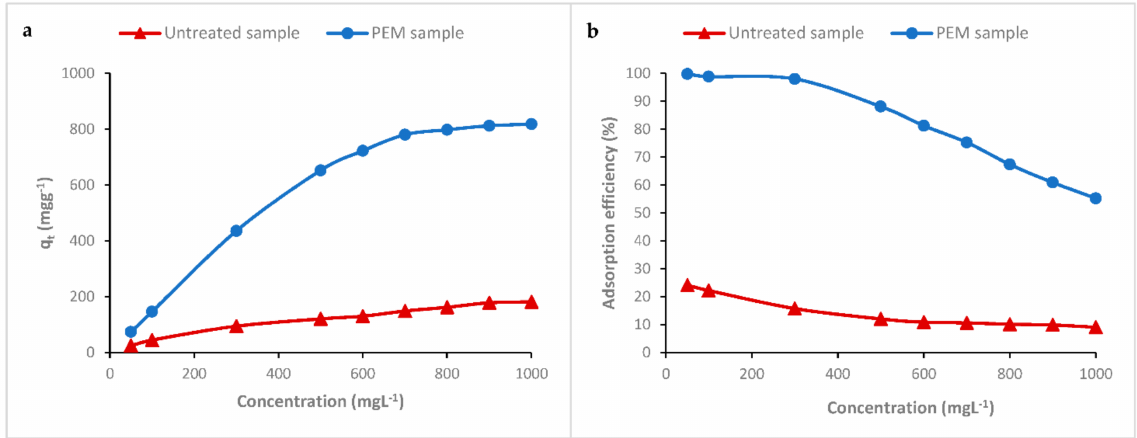
Figure 8. Effect of initial dye concentration on the adsorption of RR198 on the PEM bio-sorbent material.